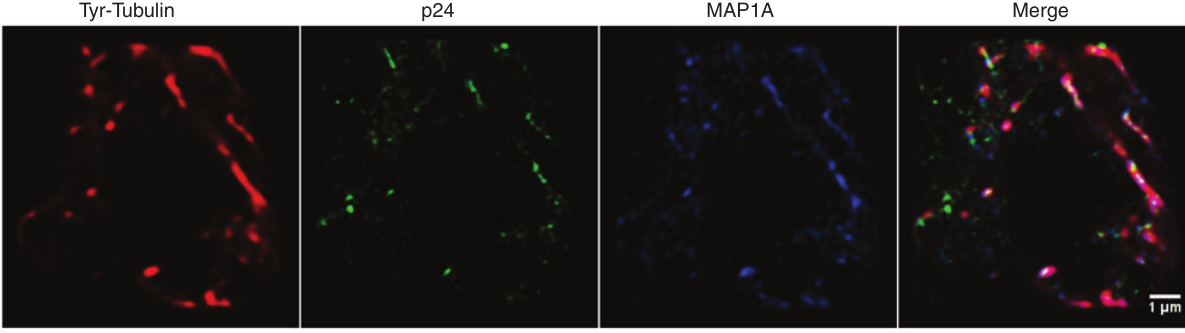
Figure 3: MAP1A interacts with HIV-1 capsid. Super resolution images of HIV-1 infected HeLa cells were acquired by BioAxial’s Conical Diffraction Microscopy (CODIM) (111) at 4 h post- infection. Cells were labeled with anti-tyrosinated (Tyr)-tubulin (red), anti-capsid p24 (green) and anti-MAP1A (blue) antibodies. Scale bar represents 1 µ